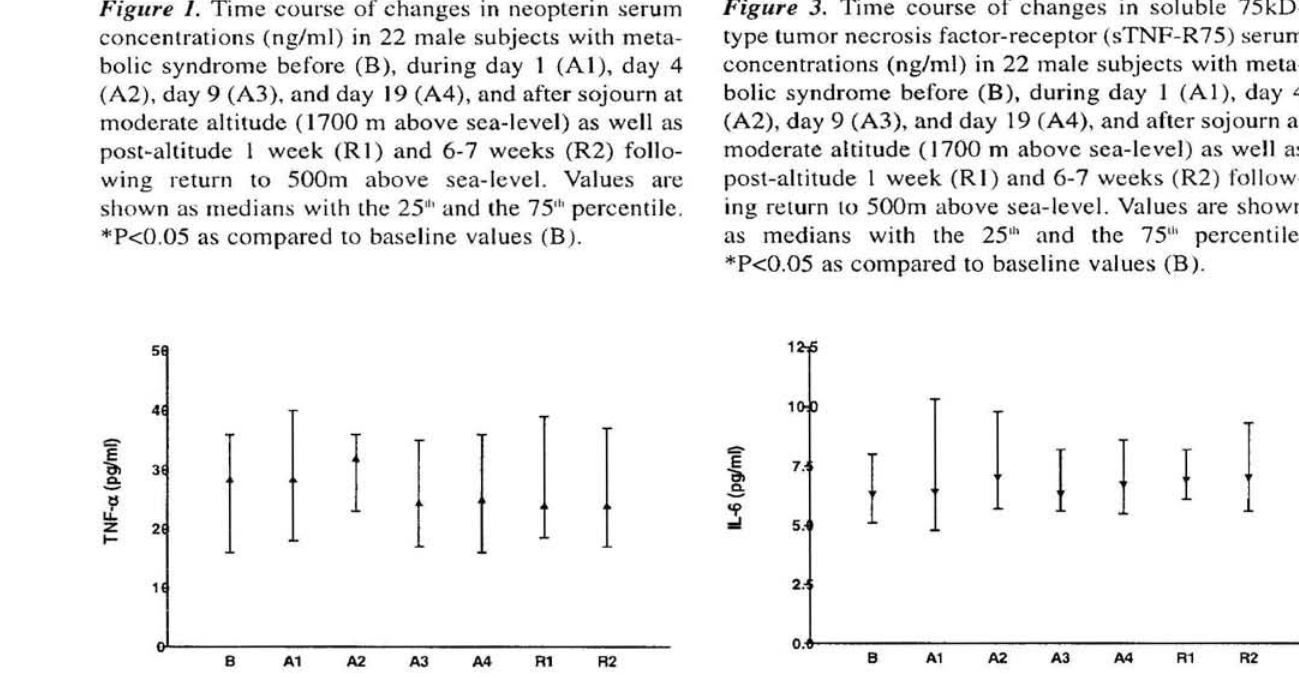
Figure 2. Time coursc of changes in tumor necrosis factor-a (TNF-a) serum concentrations (ng/ml) in 22 male subjects with metabolic Syndrome before (B), during day 1 (AI), day 4 (A2), day 9 (A3), and day 19 (A4), and after sojourn at moderate altitude (1700 m above sea-level) as well as post-altitude 1 week (Rl) and 6-7 weeks (R2) following return to 500m above sea-level. Values are shown as medians with the 25"' and the 75'" percentile.